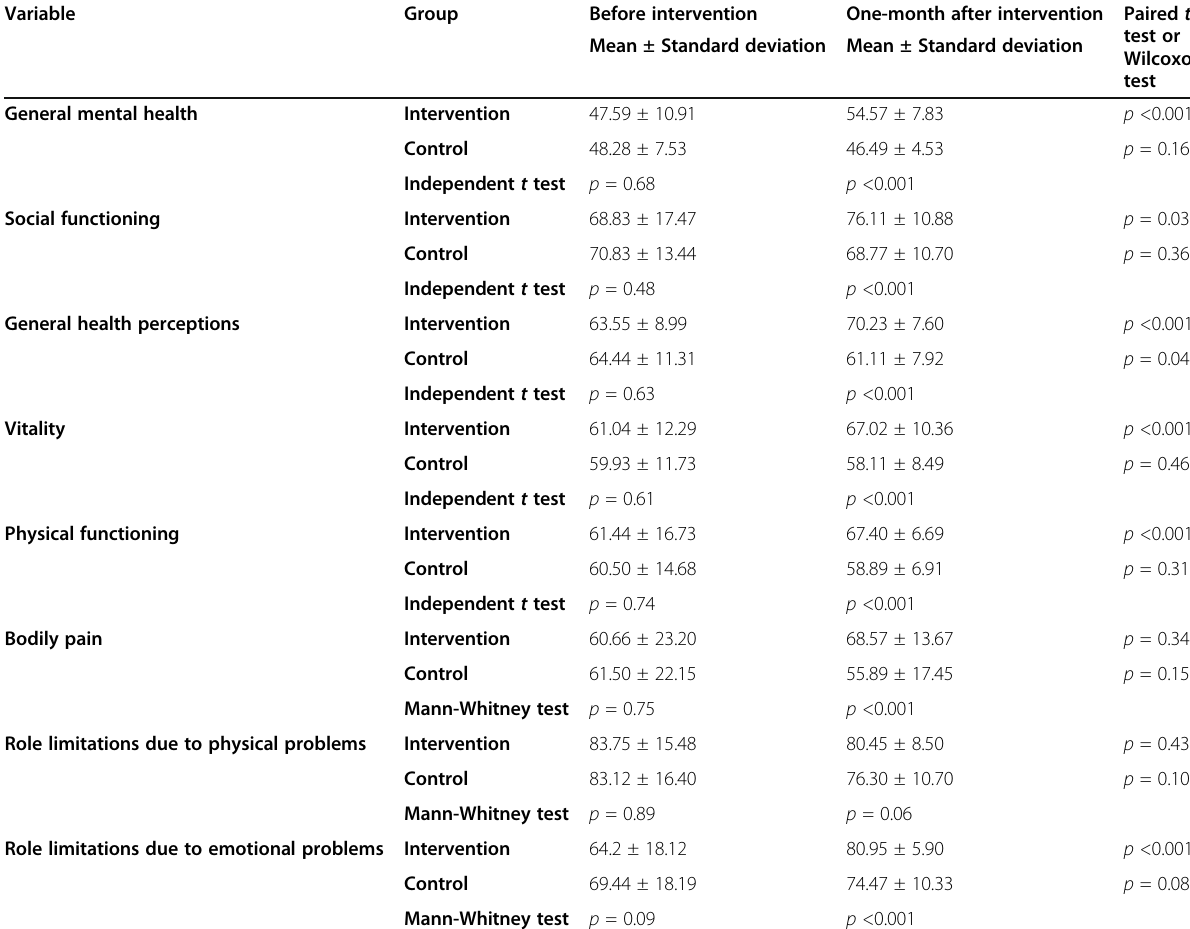
Table 2 Comparison of eight domains of patients ’ quality of life before and 1 month after intervention in the intervention and control groups (Patients discharged from 22nd Bahman Hospital of Khaf in 6 months since 2020)